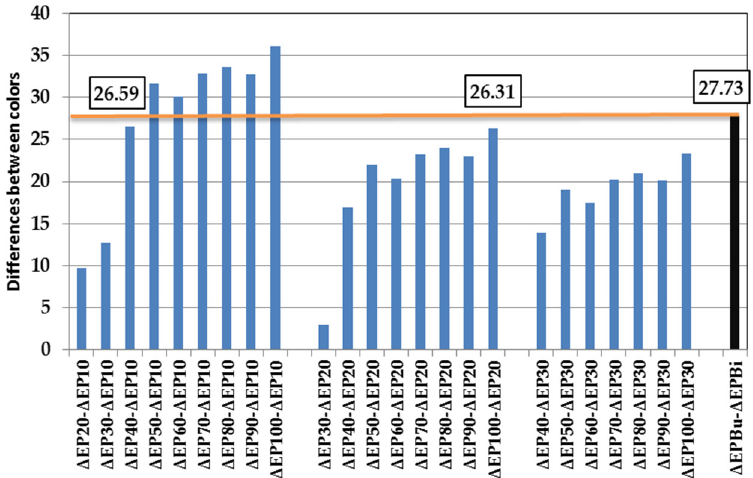
Figure 9. Comparison between the contrast assimilated differences of ∆ E values, for original colors: burgundy (Bu) and beige (Bi) and the shades of brown corresponding to the laser engraved surfaces; contrast difference values for the laser processing variants rendering contrast close to the contrast between the original colors are presented.